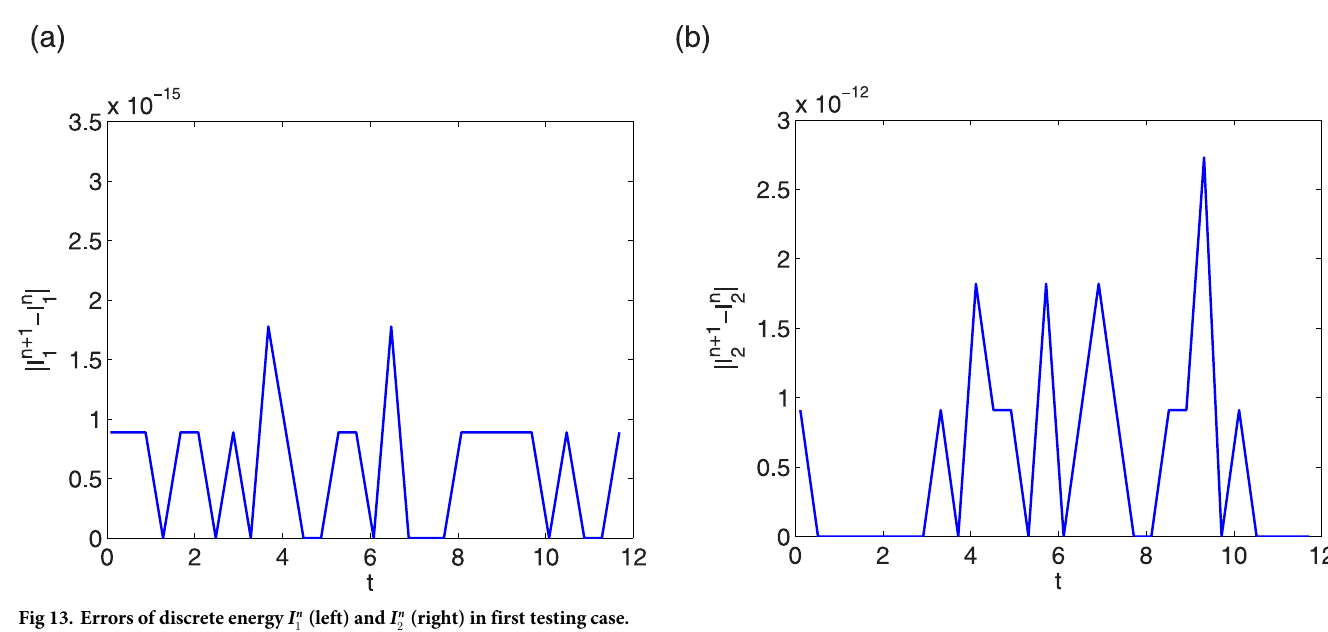
(left) and I n (right) in first testing case. 1 2